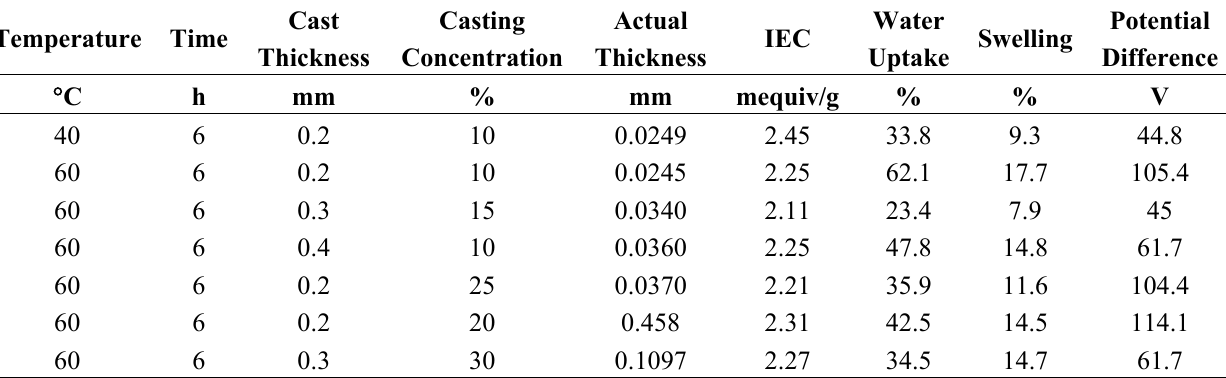
Table 3. Summary of membrane properties when sulfonated at 40–60 °C for 6